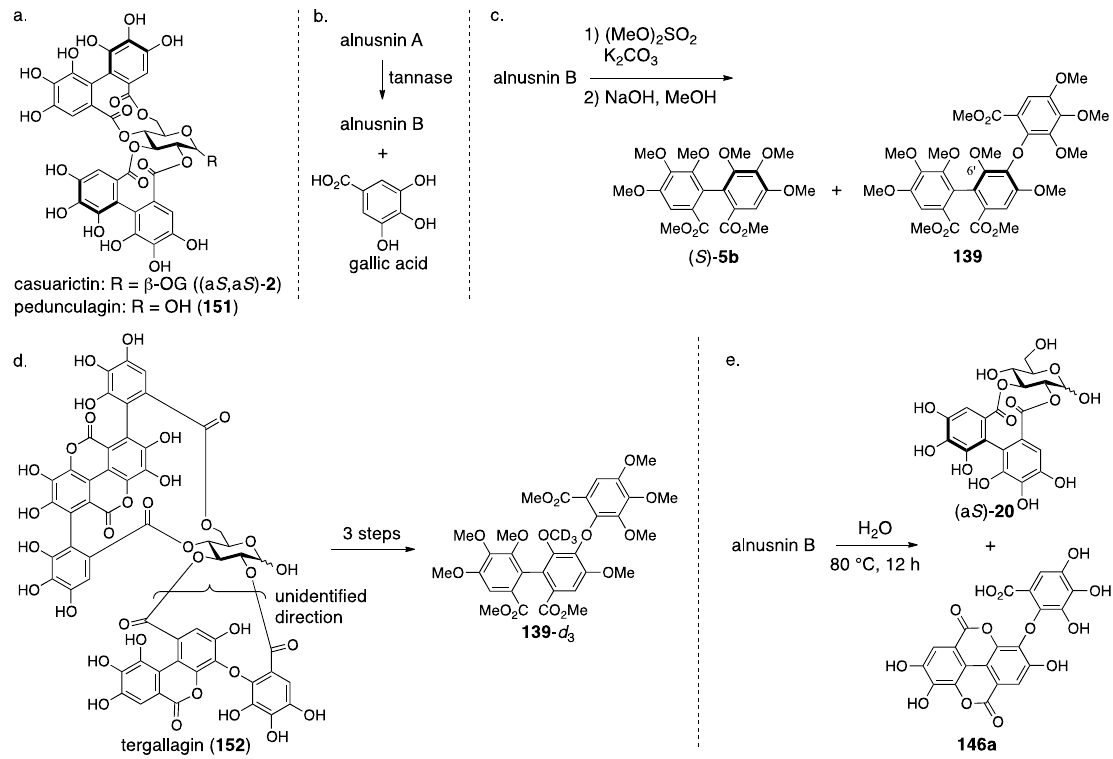
Figure 51. The transformations used in the determination of the first structures of alnusnin A ( 147 ) and B ( 149 ).